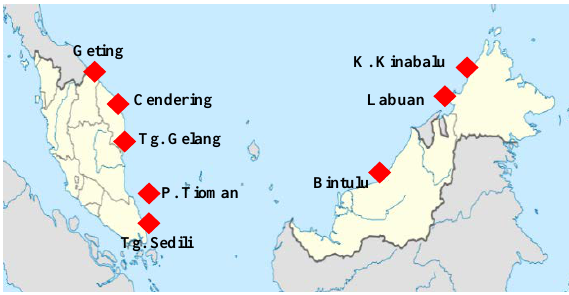
Figure 3. The distribution of tide gauge stations that was employed in data verification